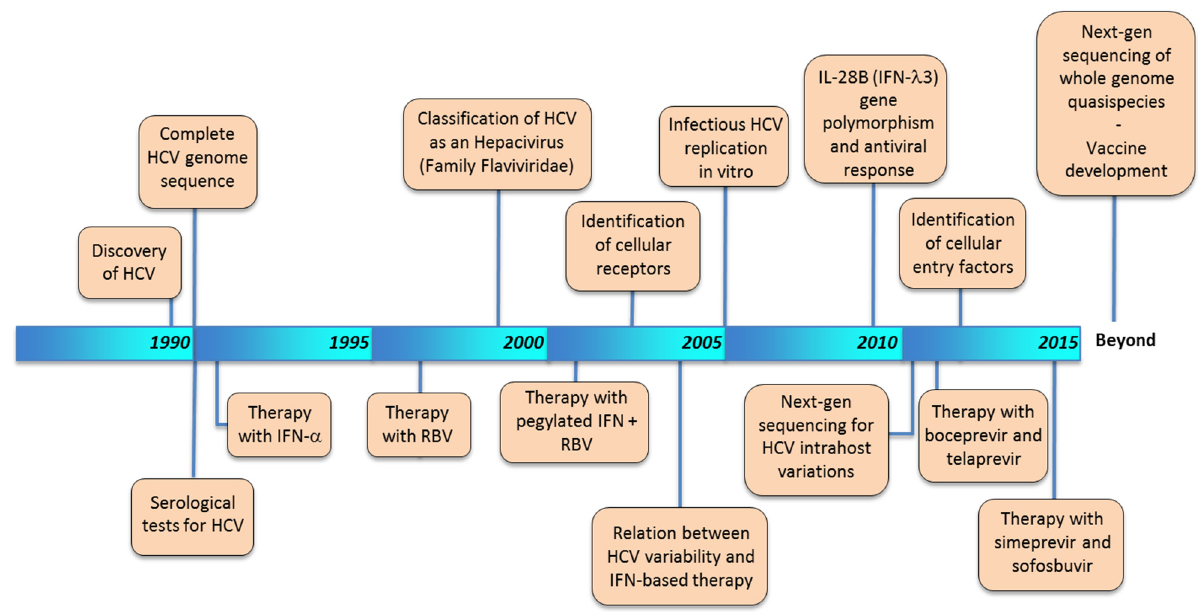
Figure 2. Chronological cornerstone developments in the field of HCV. The most relevant discoveries related to the study of HCV are shown in chronological